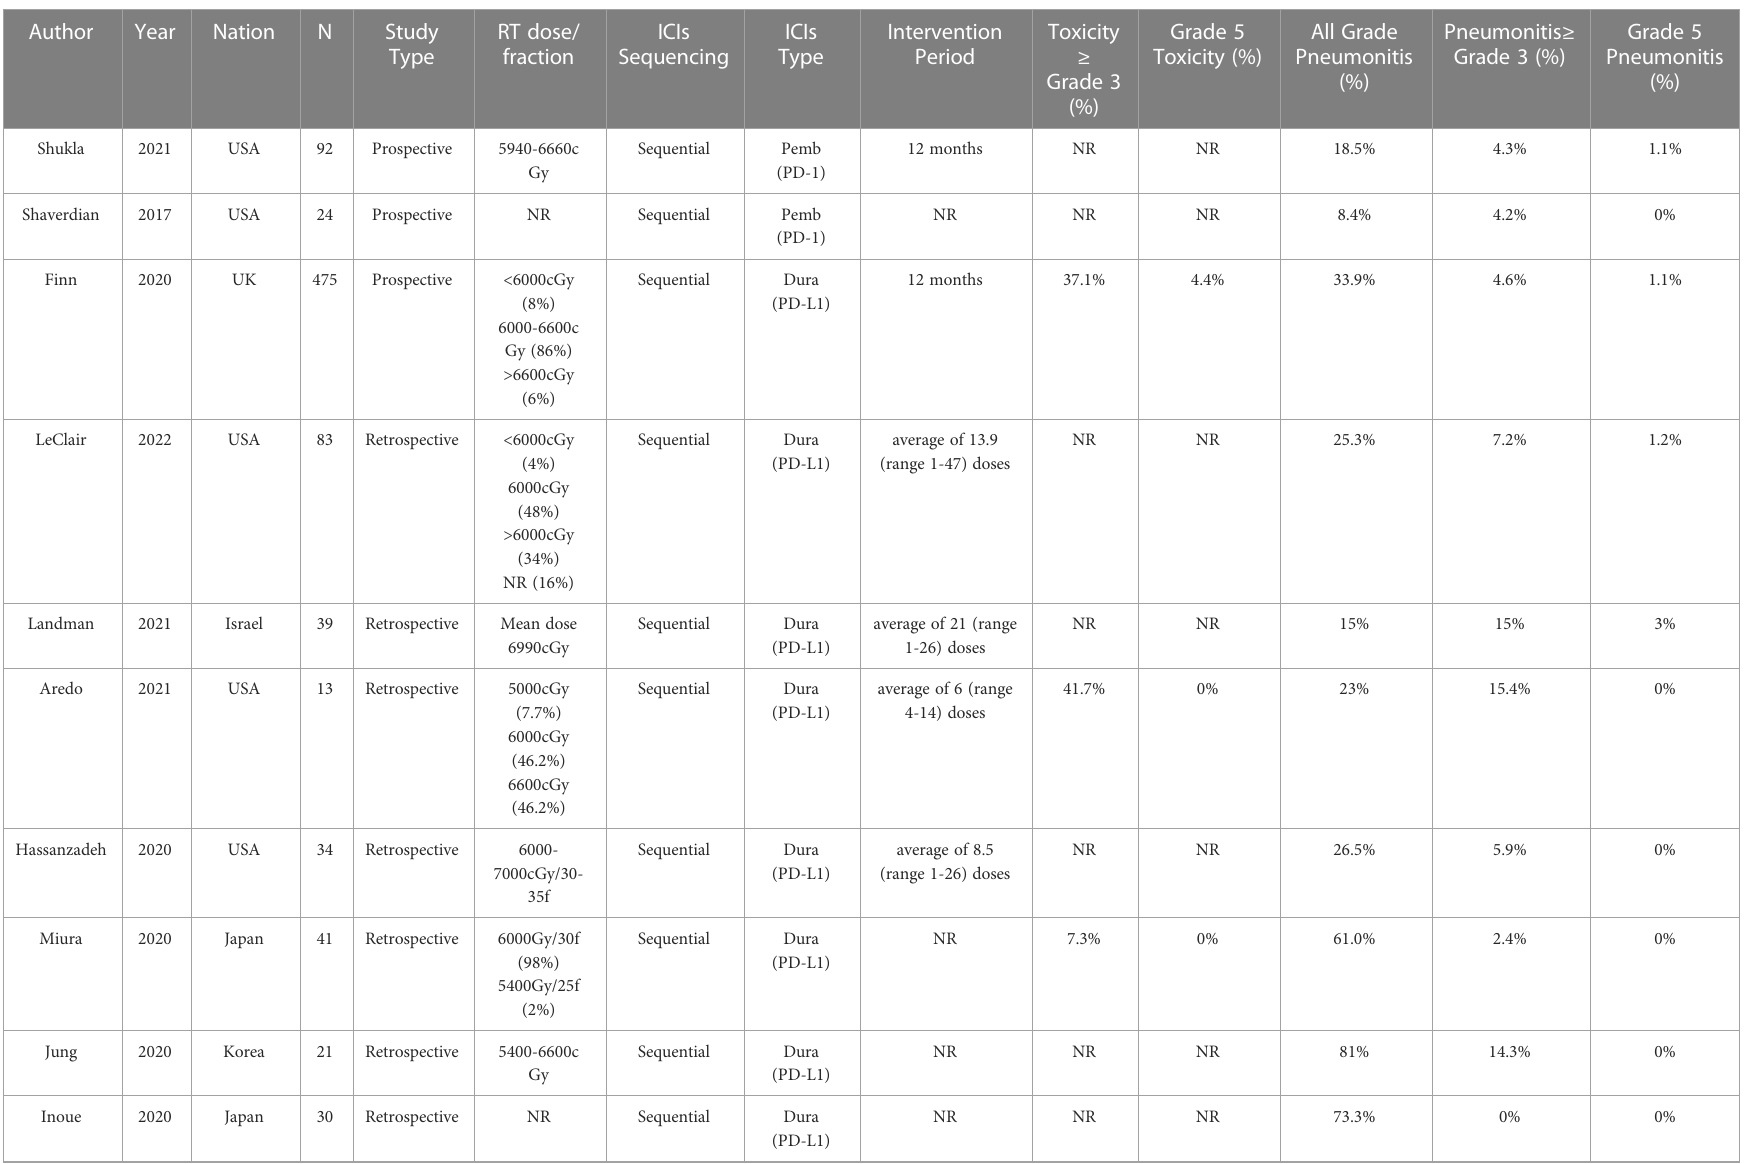
TABLE 1 Main study